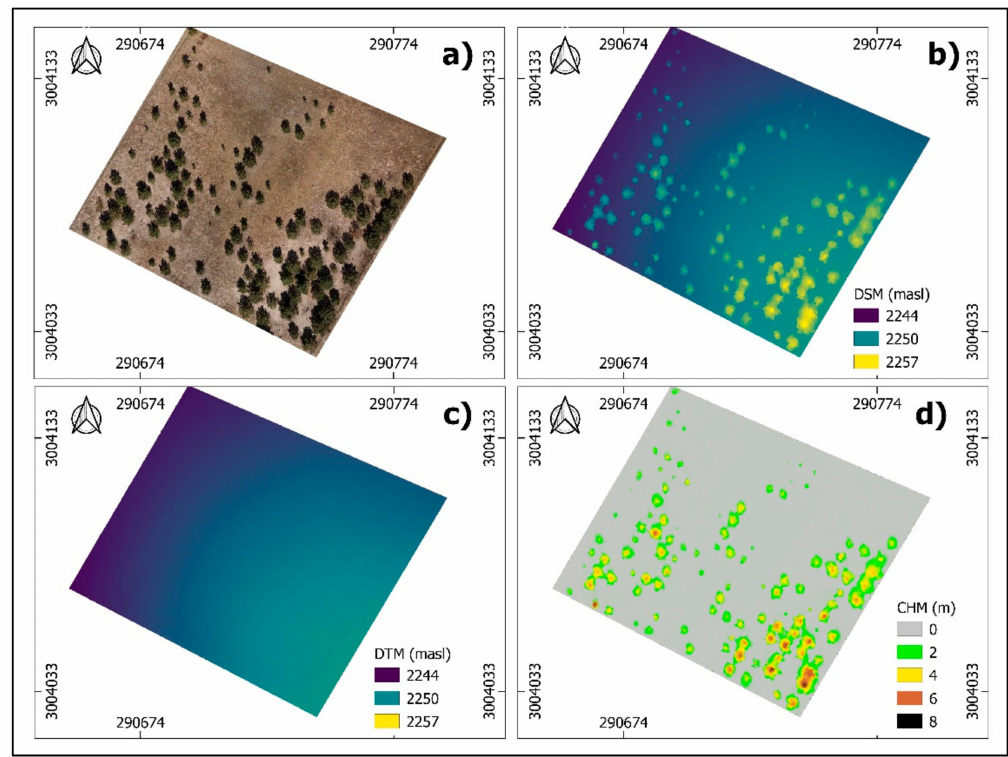
Figure 4. ( a ) RGB orthomosaic, ( b ) digital surface model, ( c ) digital terrain model, and ( d ) canopy-height model derived from UAV